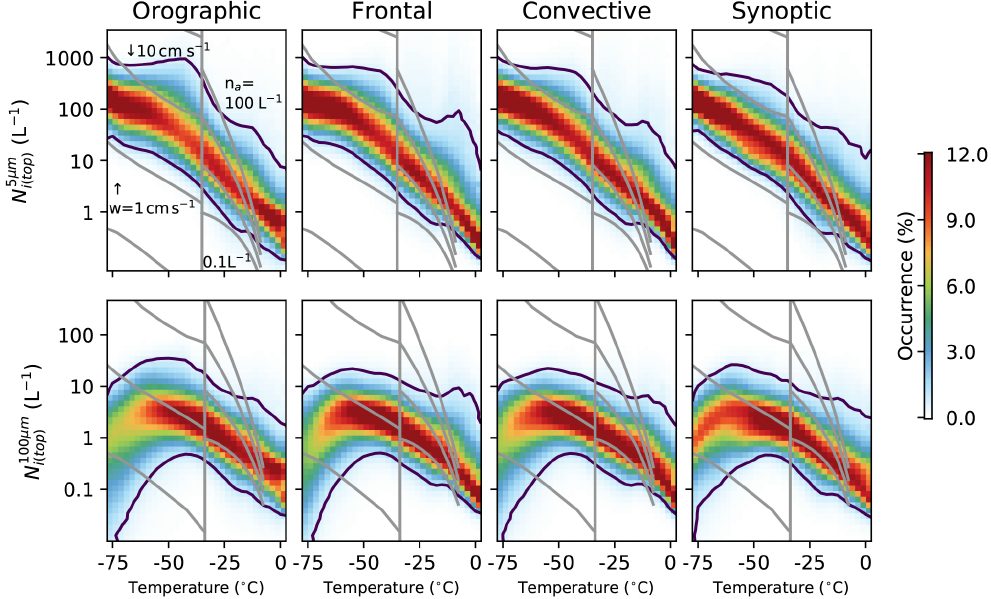
Figure 2. The conditional N i ( top ) (L − 1 ) for 5 ◦ C temperature bins for each of the main cloud regimes (orographic, frontal, convective and synoptic) from Gryspeerdt et al. (2018a, O2, F, C and S). The top row shows the N i ( top ) for particles greater than 5µm ( N 5µm ) and the i ( top ) bottom row shows the N i ( top ) for particles greater than 100µm ( N 100µm ). The columns are normalized so that they sum to 100%. The i ( top ) vertical line is drawn at − 35 ◦ C – approximately the homogeneous nucleation threshold temperature. At temperatures warmer than − 35 ◦ C, the grid lines show the INP numbers predicted by the DeMott et al. (2010) parameterization for 0.1, 1, 10 and 100L − 1 aerosols > 0 . 5µm. The grid lines at temperatures below − 35 ◦ C are the N i values following Koop et al. (2000) for 1, 10 and 100cms − 1 updraft speeds for a mean pressure and an aerosol particle number of 300cm − 3 , following Krämer et al. (2009). The regime names and definitions are given in Table 1 of Gryspeerdt et al. (2017). Note the log scale for N i ( top )